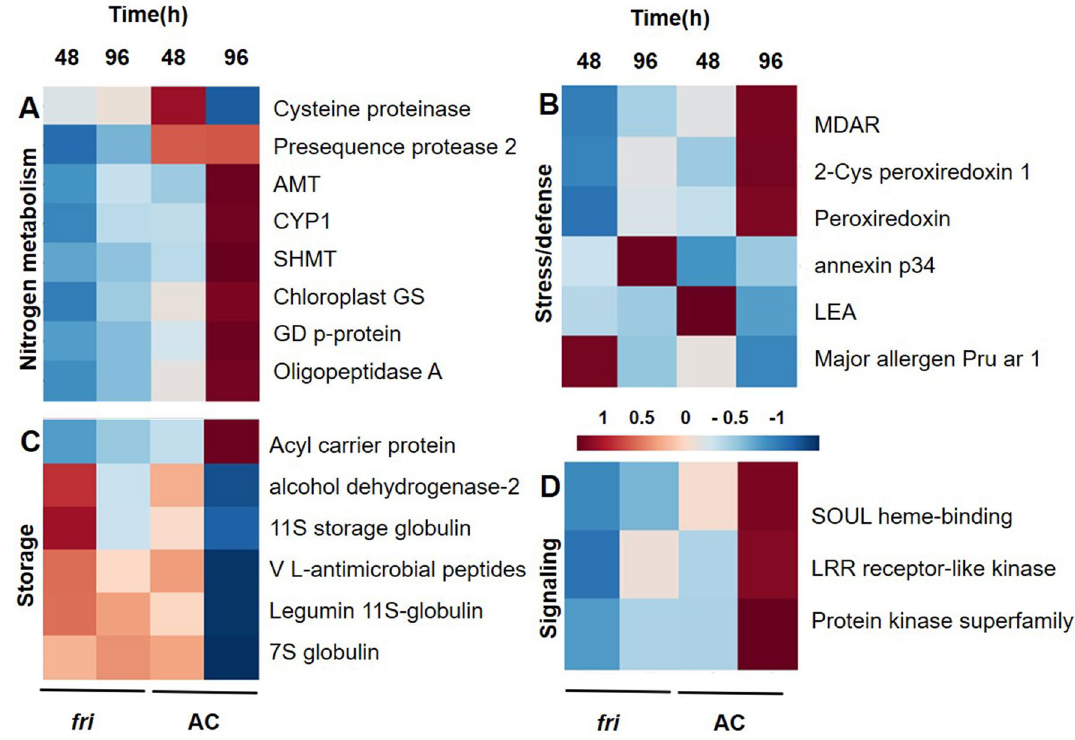
Figure 3. PhyA regulated proteins associated with nitrogen metabolism, storage, and stress/defense metabolic pathways. Heat map showing the fold ratio of differentially altered proteins involved in nitrogen metabolism ( A ), stress/defense ( B ) storage ( C ), and signaling ( D ) metabolic pathways in fri mutant in comparison to AC seedlings under FR irradiation. MDAR-Monodehydroascorbate reductase; Chloroplast GS-chloroplast glutamine synthetase; AMT-Amino methyltransferase; SHMT-Serine hydroxymethyltransferase; GD p-protein- glycine decarboxylase p-protein; cysteine protease CYP1; LEA-Late embryogenesis abundant protein; LRR- Leucine-rich